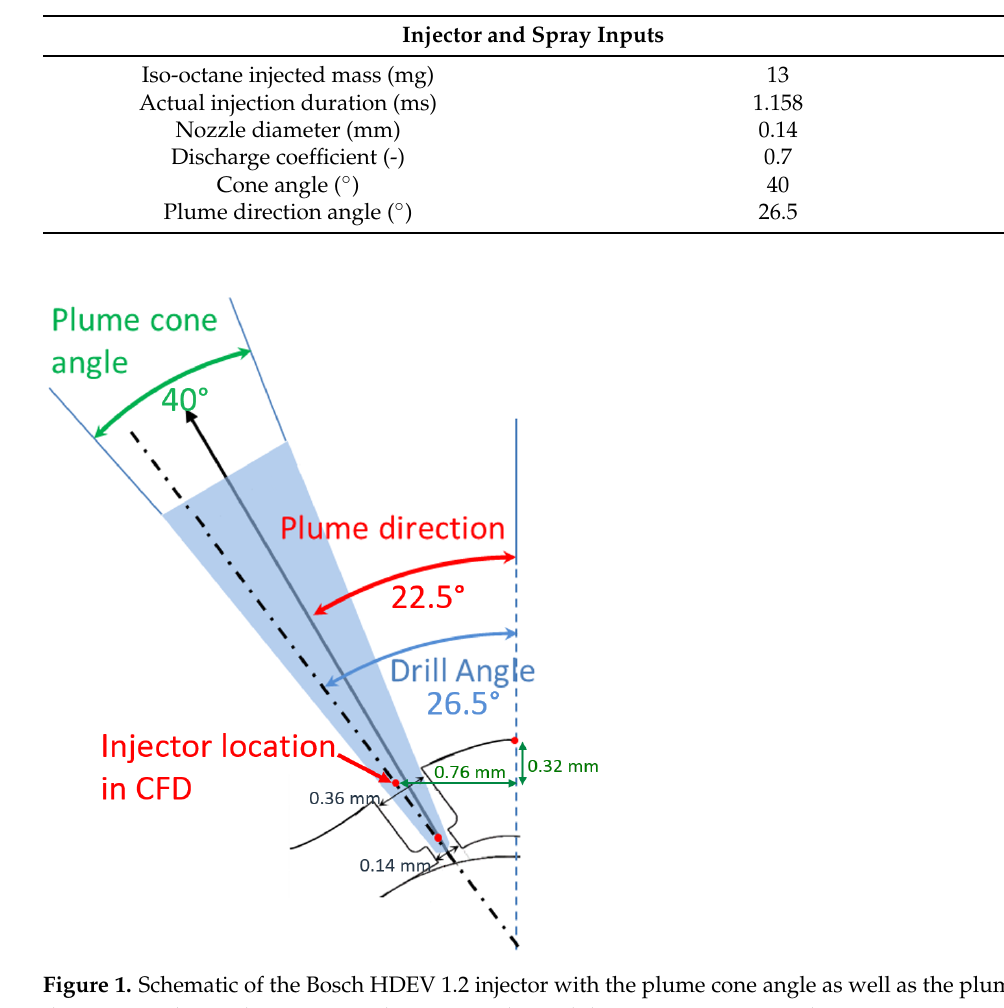
Table 2. Injector characteristics as well as spray inputs used in the simulations.